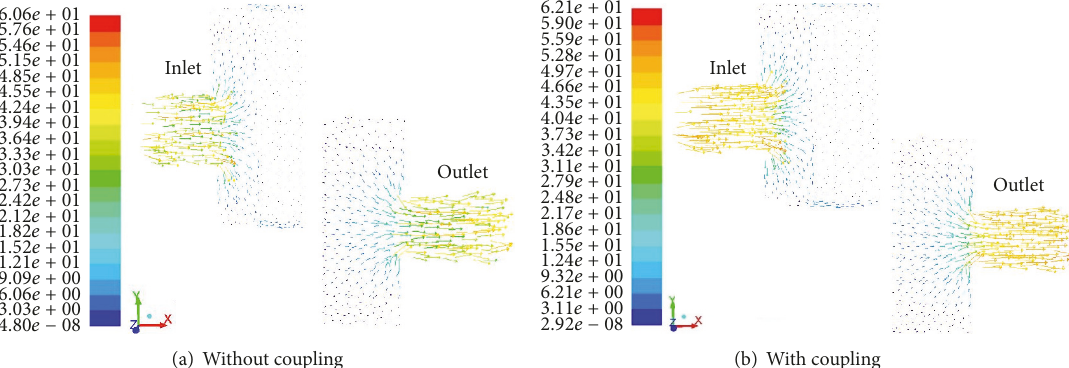
Figure 4: Velocity vector of oil-air flow at inlet and outlet.